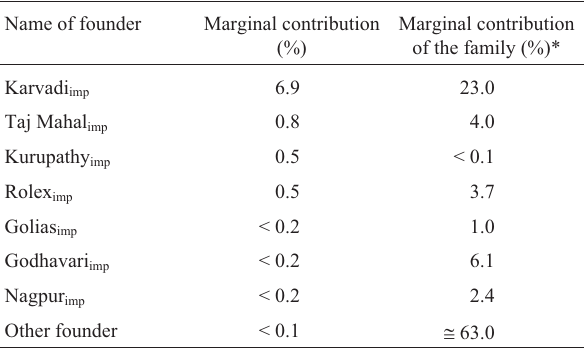
Table 4 - Genetic contributions of the principal founders and the principal descendants in the polled Nellore